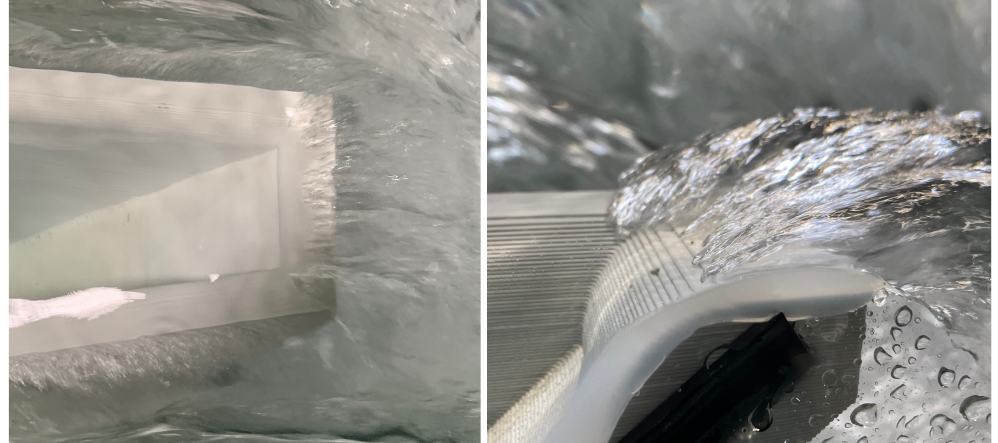
Figure 9. Detail of nappe separation induced by surface roughness, TPKW P40 , left: top view, right: side view, flow direction from left to right.